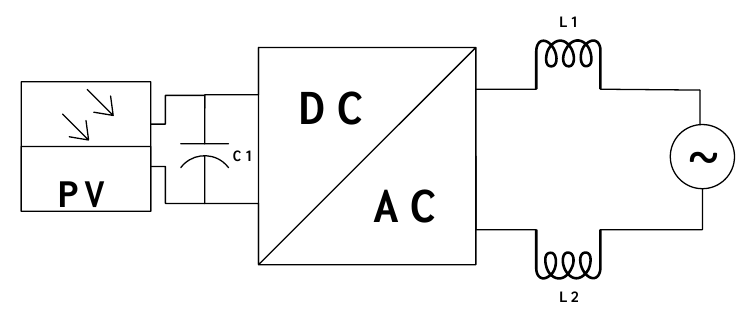
Figure 3. PV system without